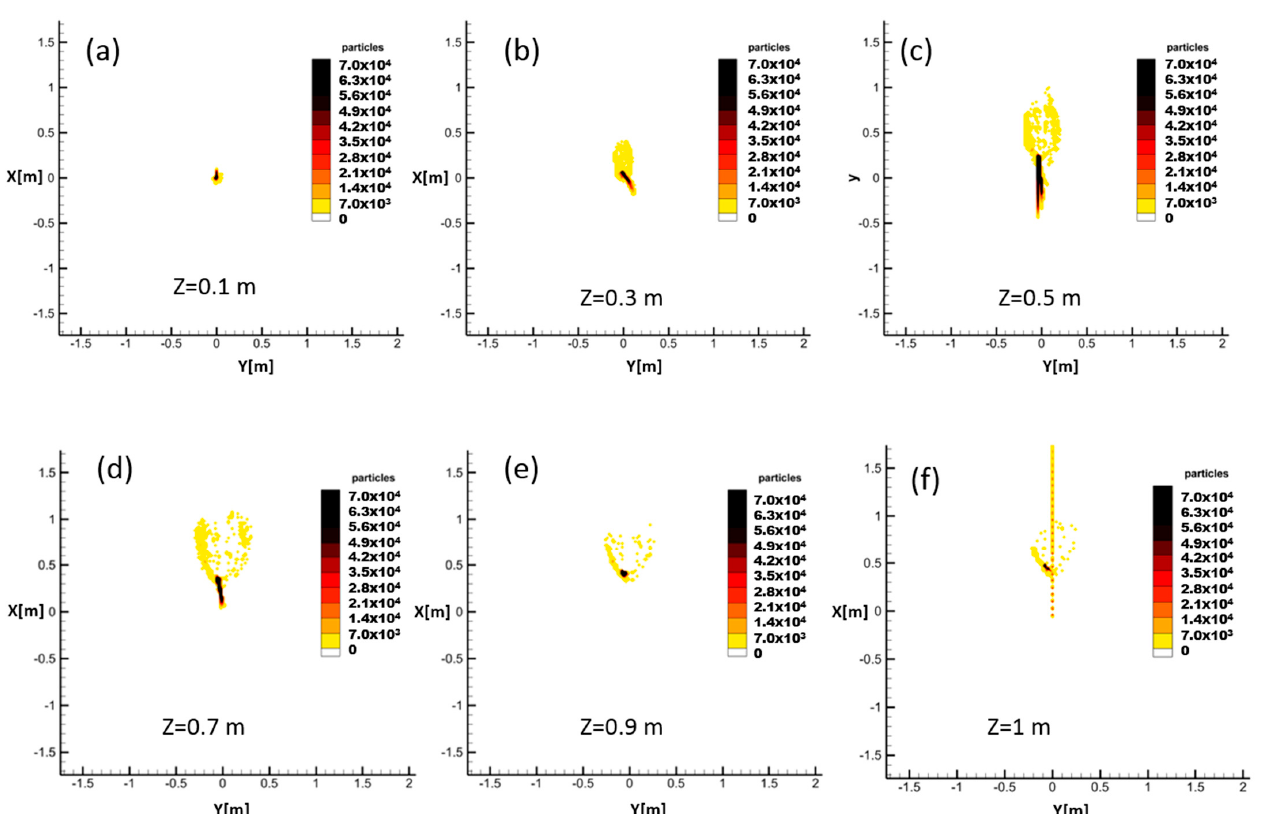
Figure 12. Distribution of accumulated droplets until t = 60 s at different cross-sections (Z-planes) of a sneeze after 60 s.